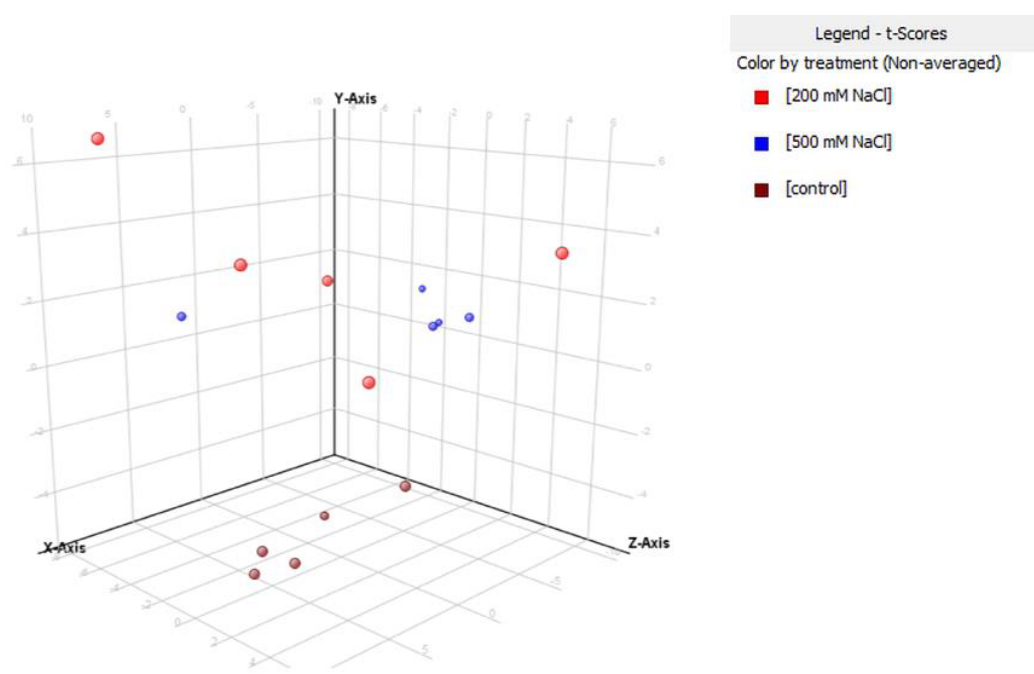
Figure 2. Partial least squares discriminant analysis (PLS-DA) on Salicornia brachiata according to their protein response to 200 mM NaCl and 500 mM NaCl. Individual replications are given in the class prediction model score plot. Table 2. Discriminant proteins in Suaeda maritima shoots under either 200 mM and 500 mM NaCl salinity, together with fold-change (FC) values and regulation.